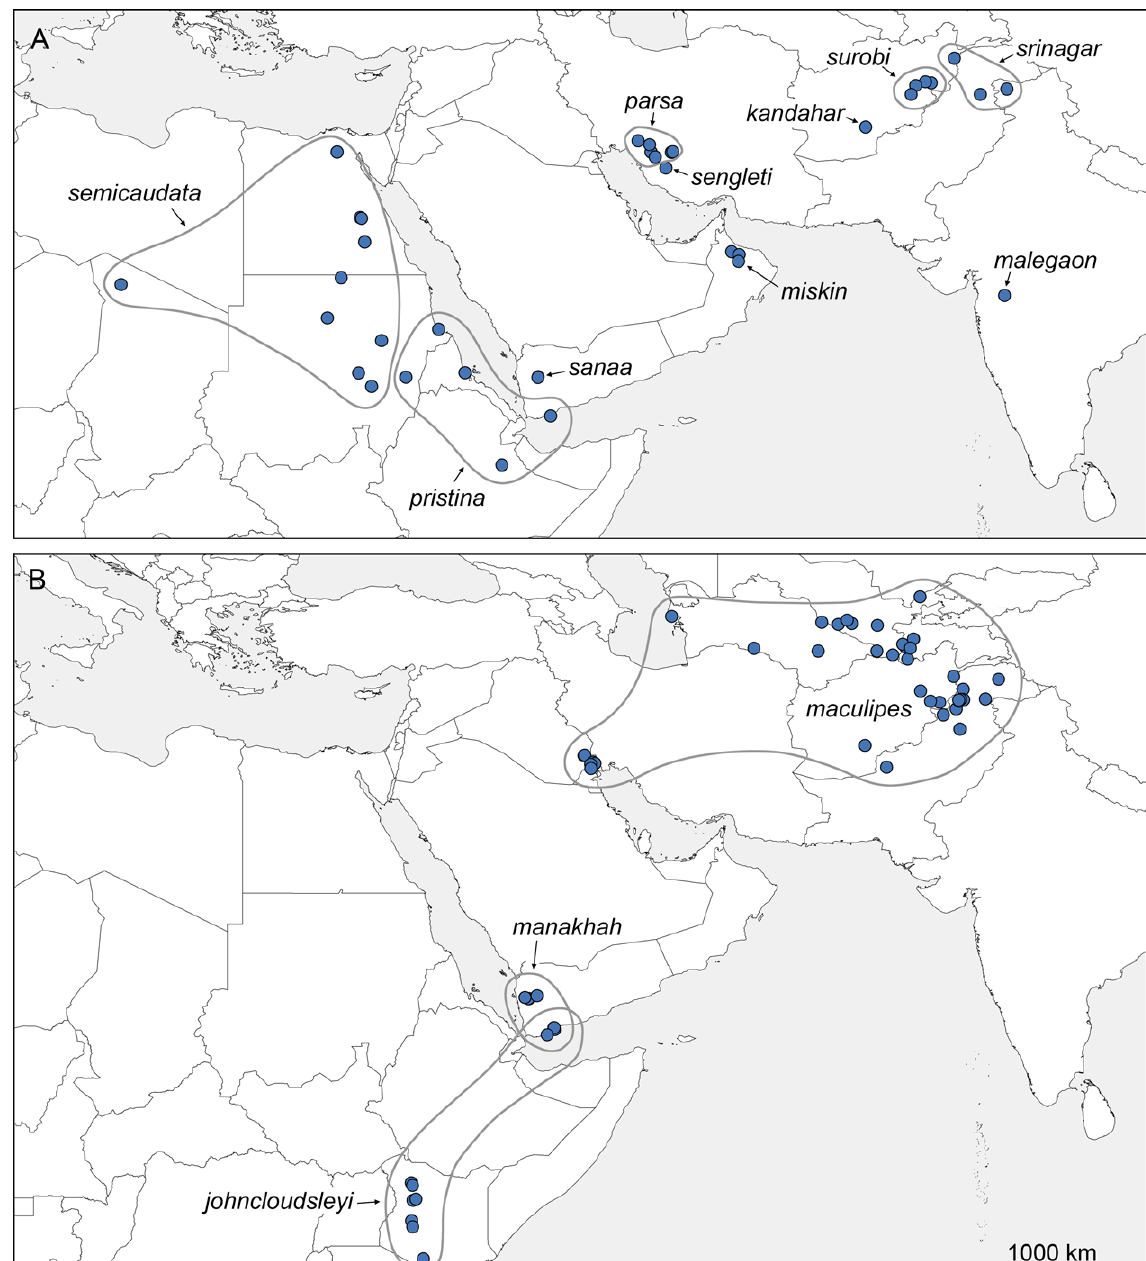
Fig. 353. Known distribution of Crossopriza Simon, 1893; autochthonous species part 2 (cf. Fig. 352): species with main cheliceral apophyses in frontal position and epigynal pockets close together. The figure is split into two to avoid too much overlap; the split is not meant to reflect any natural grouping of species. The single record of C. maculipes from China is not shown (see